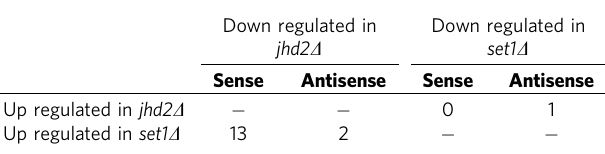
ribosome biogenesis hypergeometric distribution) (Fig. 1e; Supplementary Data 3). Therefore, Set1 and Jhd2 are negative regulators of transcription at a sub-set of